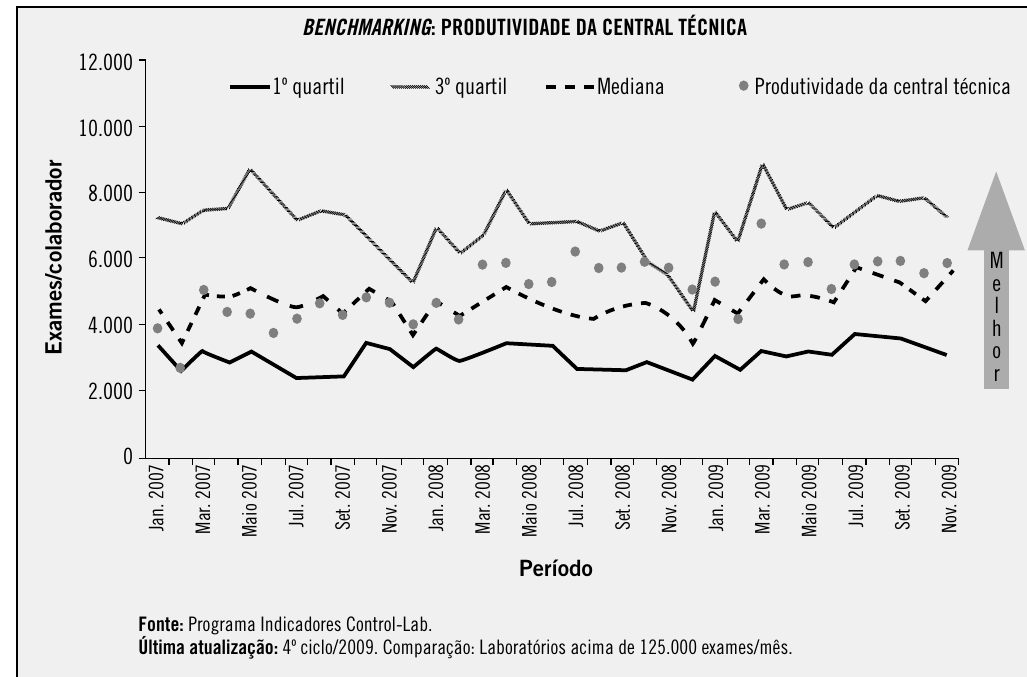
Fonte: Programa Indicadores Control-Lab. Última atualização: 4º ciclo/2009. Comparação: Laboratórios acima de 125.000 Figura 4 – Evolução da produtividade de pessoal técnico na central técnica do laboratório durante o projeto de redesenho de processos, contextualizada com os resultados do programa Indicadores Laboratoriais Control-Lab/SBPC-ML ( benchmarking )